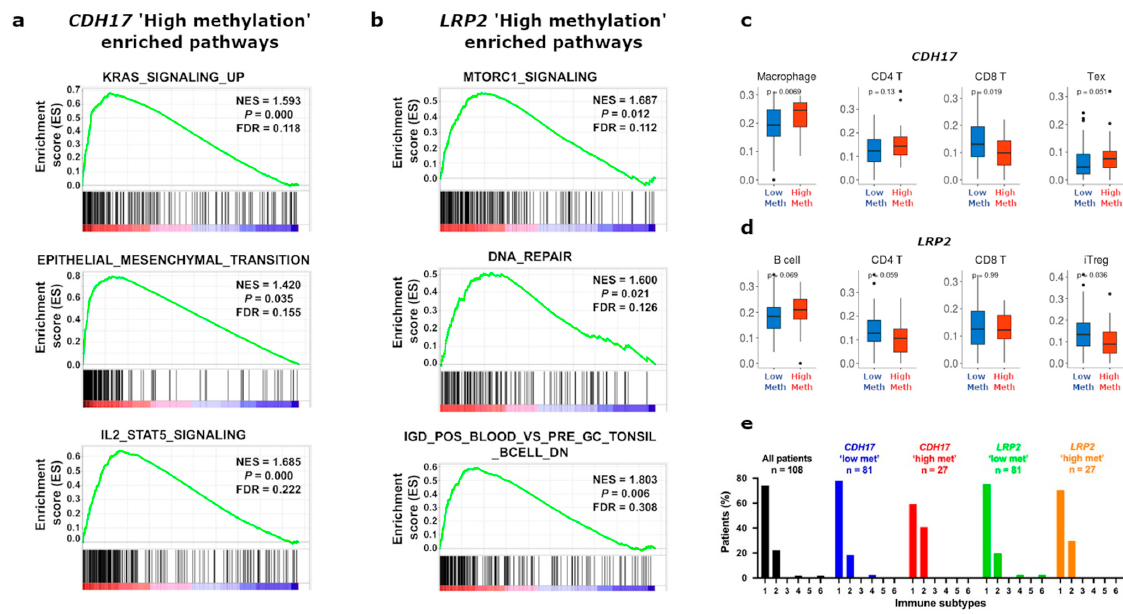
Figure 4. Functional and immune signatures according to CDH17 and LRP2 methylation status in stage II CC (TCGA). ( a ) Enrichment plots from GSEA analysis, according to CDH17 methylation status, showing three hallmark gene sets (H) significantly enriched in the hypermethylated CDH17 stage II CC tumours, as follows: IL2_STAT5_SIGNALING, KRAS_SIGNALING_UP and EPITHE- LIAL_MESENCHYMAL_TRANSITION (normalised enrichment score (NES) of 1.69, 1.59 and 1.42, a p -value of 0.00, 0.00 and 0.04 and a false discovery rate (FDR) of 0.22, 0.12 and 0.16, respectively: Q4 hypermethylated CDH17 cases; left side of GSEA plots, as indicated). ( b ) Enrichment plots from GSEA analysis, according to LRP2 methylation status, shows two hallmark gene sets (H) and one immunologic signature gene set (C7) that are significantly enriched in LRP2 high methylation stage II CC cases compared to all other cases, as follows: DNA_REPAIR, MTORC1_SIGNALING and GSE12845_IGD_POS_BLOOD_VS_PRE_GC_TONSIL_BCELL_DN with NES scores, respectively, of 1.60, 1.69 and 1.80, p -values of 0.02, 0.01 and 0.01 and FDR of 0.13, 0.11 and 0.31. Q4 hypermethylated LRP2 cases; left side of GSEA plots, as indicated. ( c ) Box plots from ImmuCellAI analysis showing immune cell subset abundance between CDH17 ‘Low methylation’ (quartile groups Q1/Q2/Q3) versus CDH17 ‘High methylation’ (Q4) subgroups, respectively ( p -values, as indicated). ( d ) Box plots from ImmuCellAI analysis showing immune cell subset abundance between LRP2 ‘Low methylation’ (quartiles groups Q1/Q2/Q3) and LRP2 ‘High methylation’ (Q4), respectively ( p -values, as indicated). ( e ) Bar charts showing immune landscapes by iAtlas analysis: percentage of CC tumours classified according to six different immune subtypes (numbered 1 to 6 on x-axis: 1, Wound Healing; 2, IFN γ - Dominant; 3, Inflammatory; 4, Lymphocyte Depleted; 5, Immunologically Quiet; 6, TGF β -Dominant (see text for